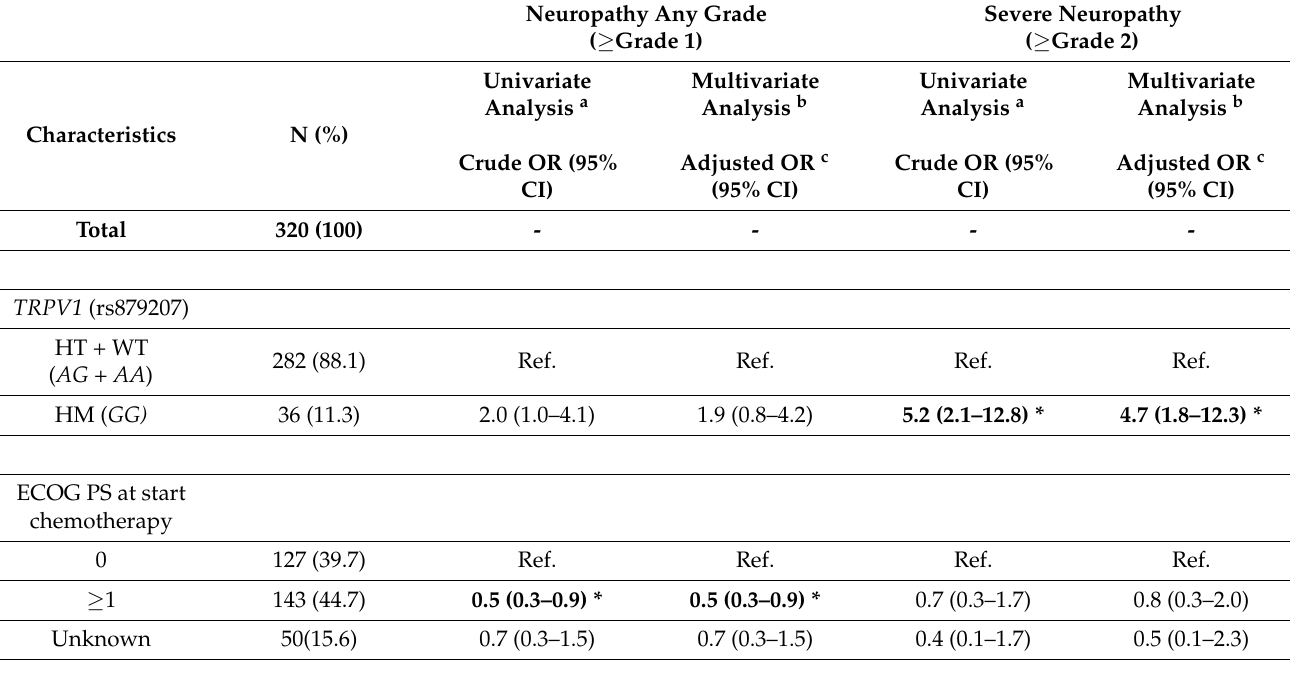
Table 3. Multivariate analysis of (severe)